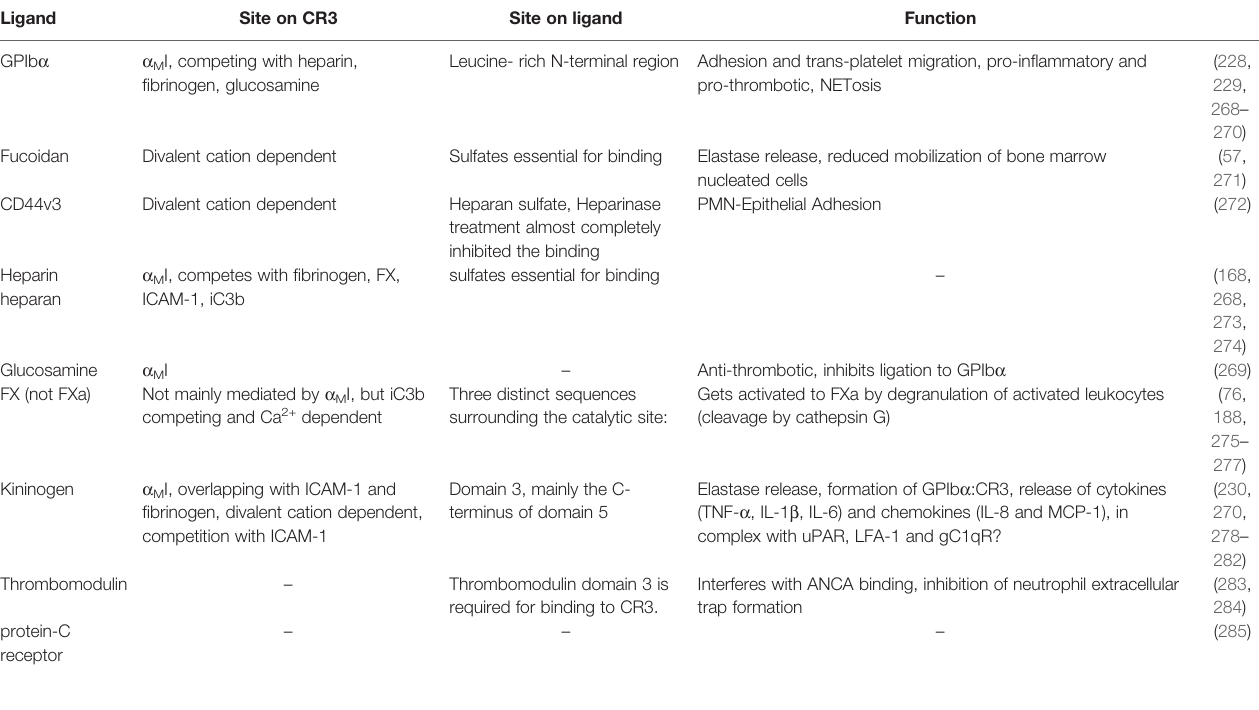
TABLE 7 | Leukocyte interaction with homeostasis and